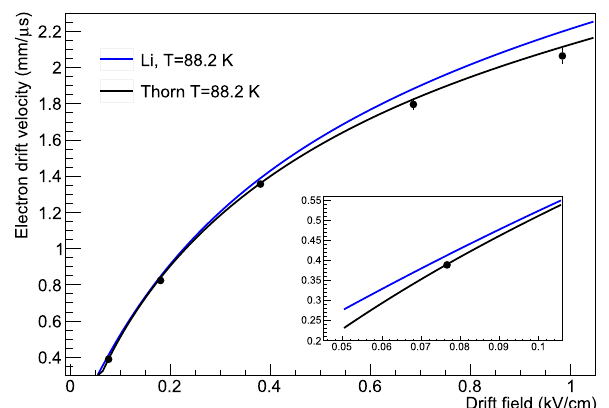
Fig. 11 Electron drift velocity in LAr as a function of the drift field ( E d ), calculated according to the parameterisations in [32] (black line) and [33] (blue line) at T = 88 . 2 K, superimposed with the experimental data.Theinsetshowsazoomedviewofthedatapointat E d = 76 . 7V/cm